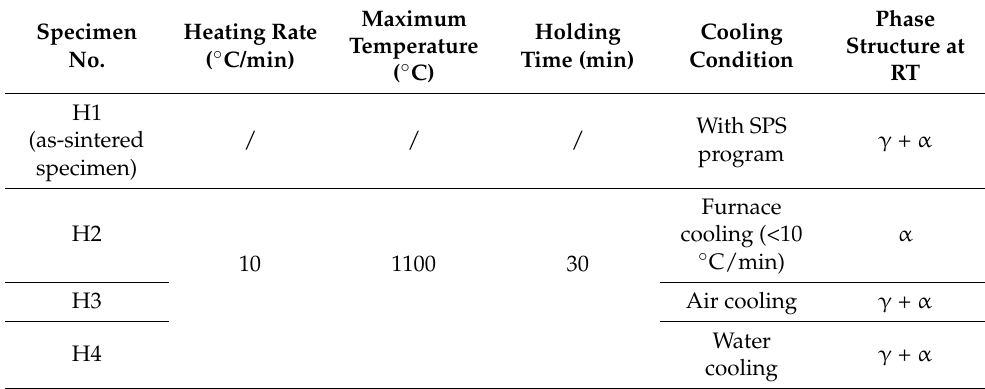
Table 5. Different cooling rates and phase structures of specimens at